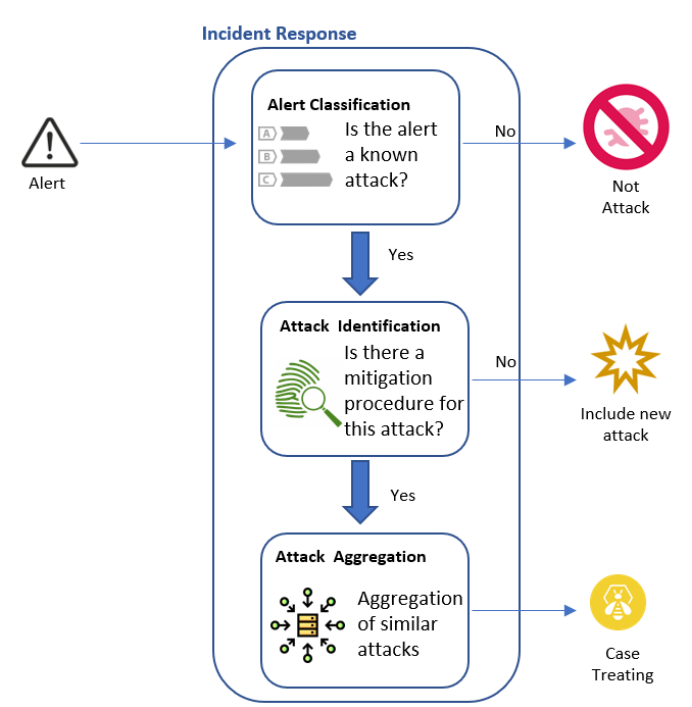
Figure 7. SMS-I Incident Response module